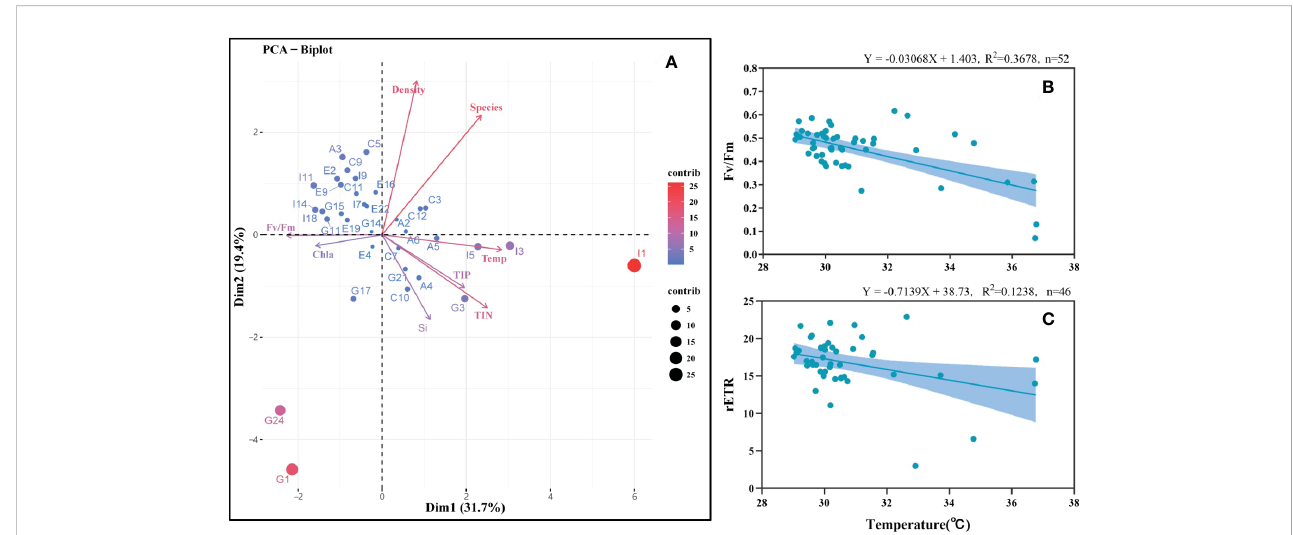
FIGURE 6 Relationships between the environmental parameters and phytoplankton community. (A) principal component analysis (PCA) biplot shows the variables for both environmental parameters and phytoplankton characteristics in all sampling stations. (B) correlation analysis between the maximal photochemical quantum yield ( F v /F m ) and temperature in the survey area. (C) correlation analysis between the relative electron transport rate (rETR) and temperature in the survey